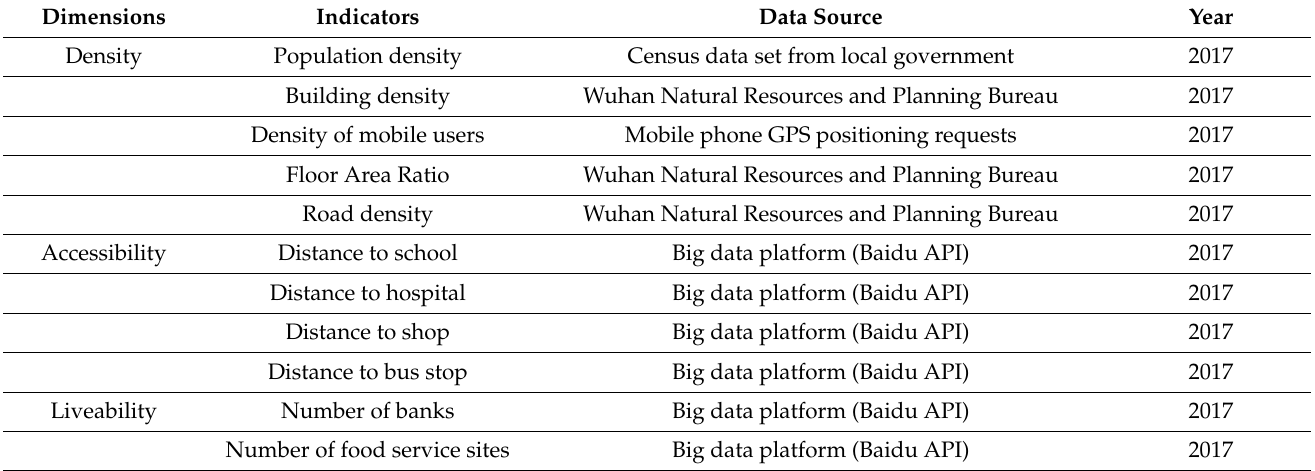
Table 1. Descriptions of DALDH